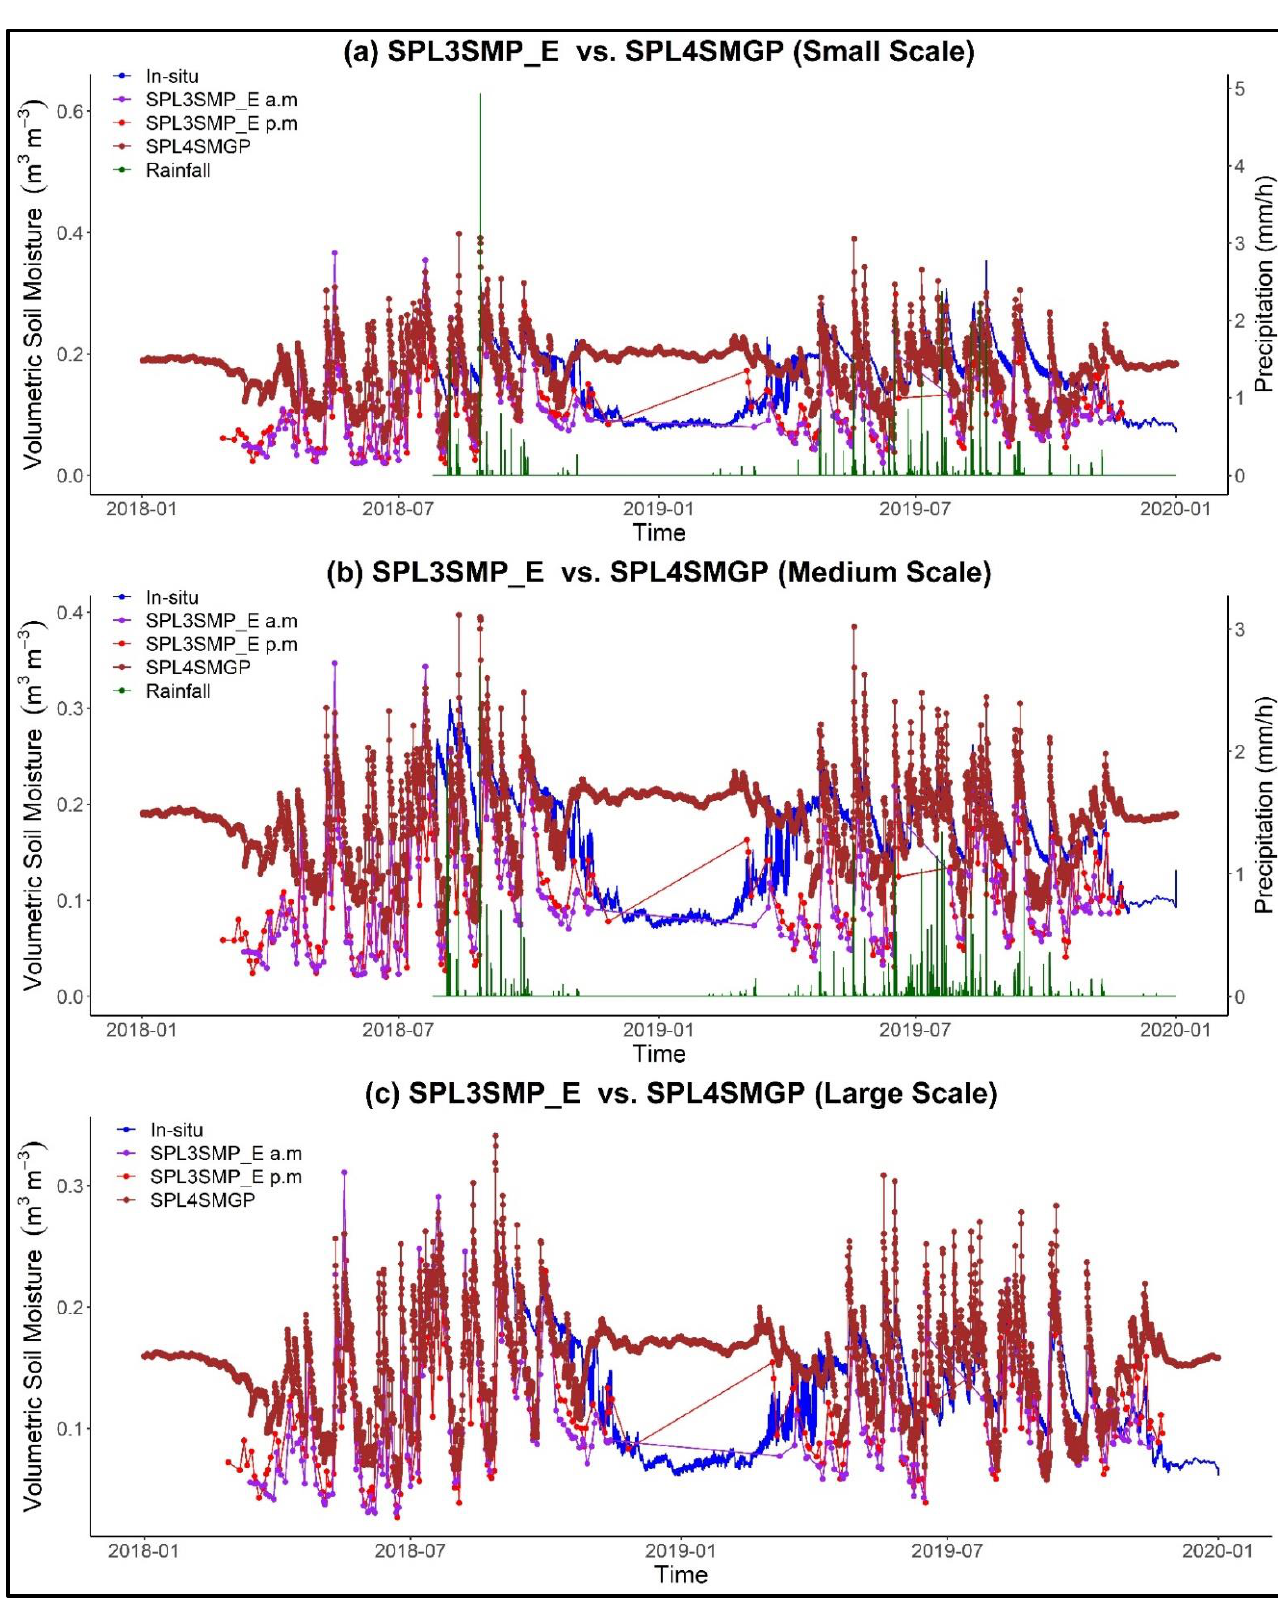
Figure 10. Comparison of SPL3SMP_E (a.m.), SPL3SMP_E (p.m.) and SPL4SMGP SSM and station averaged in situ data (hourly composite of SSM) at different spatial locations, ( a ) S-scale stations, ( b ) M-scale stations, ( c ) L-scale stations.